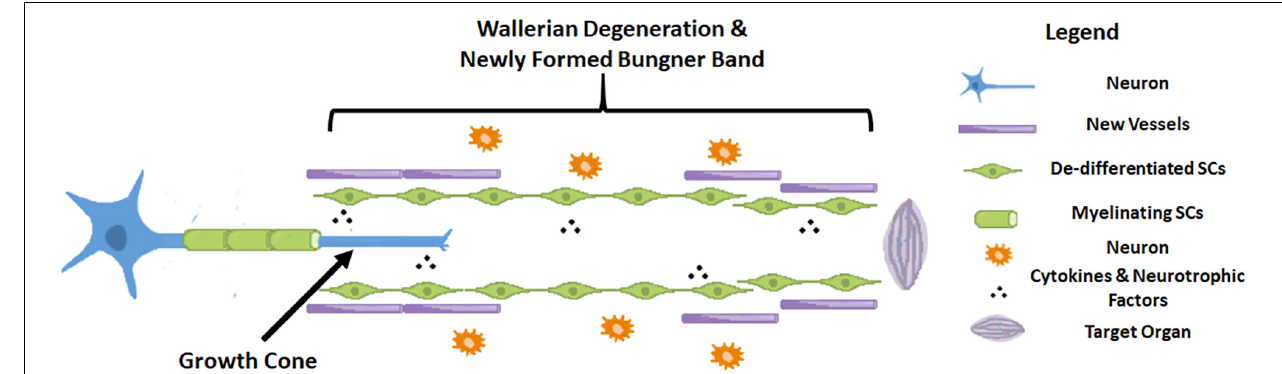
FIGURE 8 | Schematic diagram of a nerve after